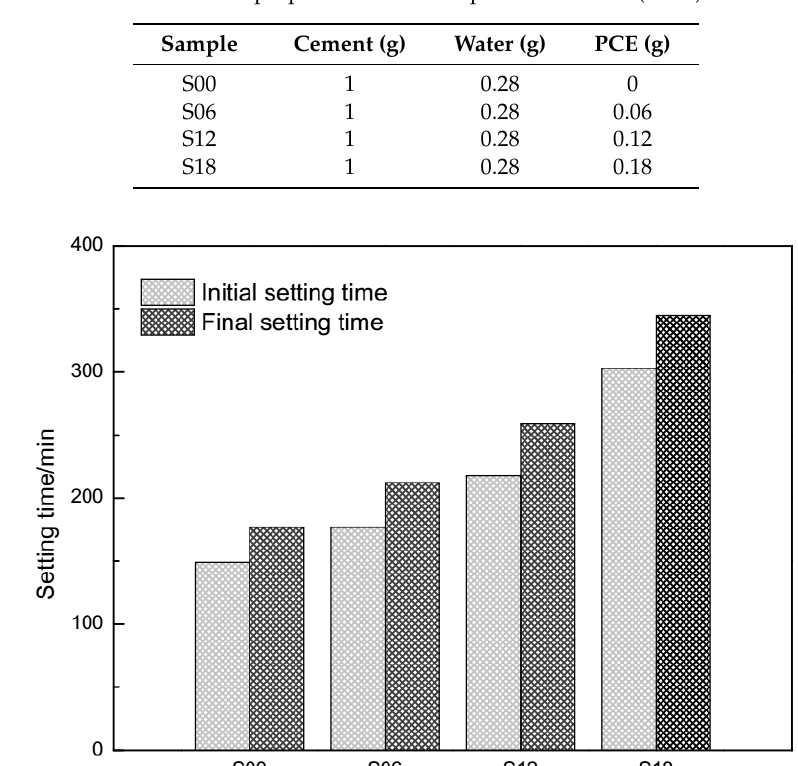
Figure 2. Effects of the synthesized PCEs on the setting time of cement pastes. Figure 2. E ff ects of the synthesized PCEs on the setting time of cement